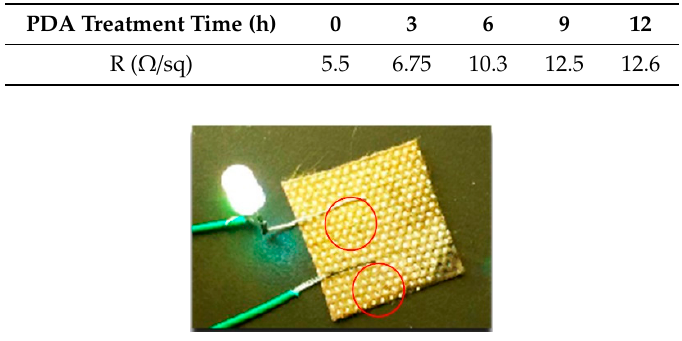
Figure 7. Photograph of the treated fabric (PDA 12 h) as a wire for powering an LED bulb.